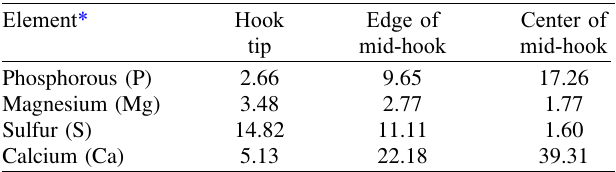
Table 4. Chemical composition of proboscis hooks of Pro fi licollis altmani cystacanths from Emerita analoga in